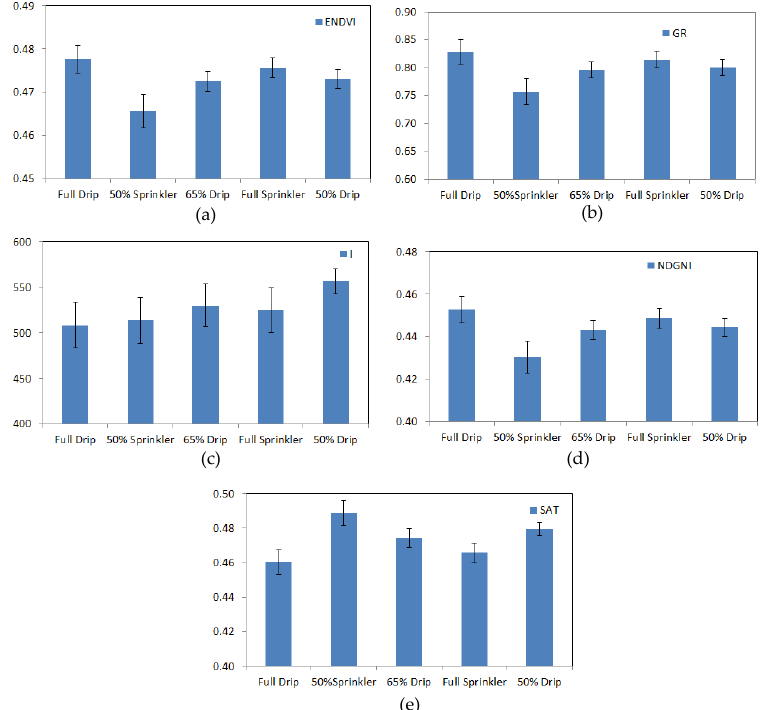
Figure 9. Average vegetation indices of the different irrigation methods: ( a ) ENDVI; ( b ) GR; ( c ) I; ( d ) NDGNI; ( e ) SAT.